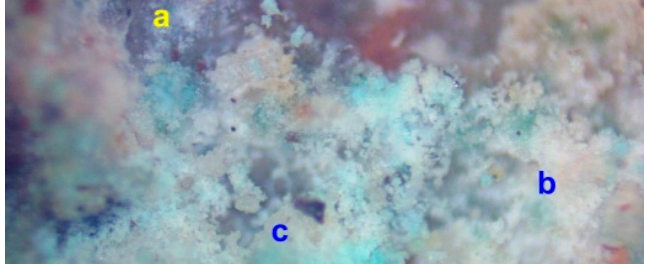
Figure 10. (ST3c Trial [16]) Pore within the ZVI product which is partially filled with NaCl (halite) crystals (blue-white). Reflected light. Field of view = 0.465 mm. a = ZVI (principally FeOOH species, i.e., goethite [43–47]). b = halite (NaCl) [41]; c = incompletely filled pore where the halite crystallites are growing into the pore from the pore edges. ZVI:water ratio = 30.12 g/L; Feed water salinity = 10.06 g/L; Product water salinity after 230 days = 2.82 g/L. NaCl removed = 7.24 g/L (0.234 g/g ZVI). Feed water pH = 6.31; Product water pH = 8.44.